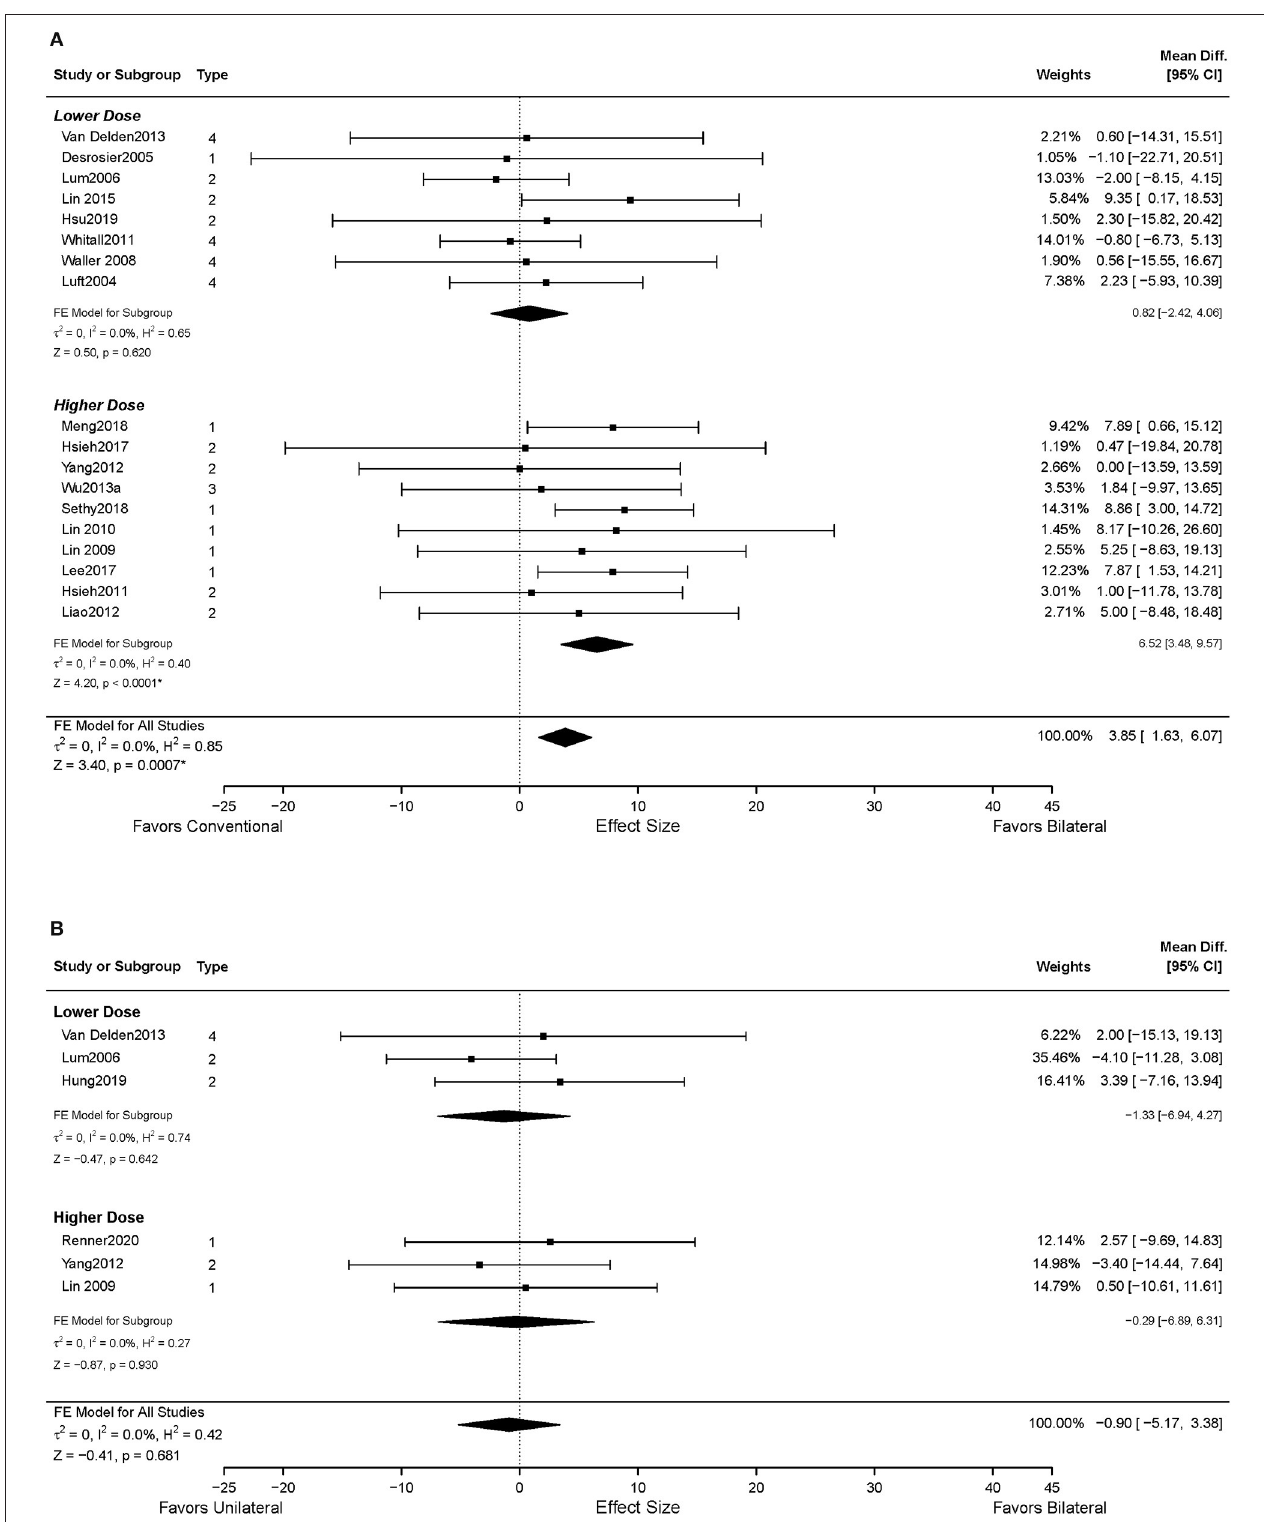
FIGURE 4 | The effects of intervention dose on the UE motor impairment. (A) BAT vs. CT; (B) BAT vs. UAT. 1 = bilateral functional training Test (BFTT); 2 = bilateral robot-assisted training (BRAT); 3 = bilateral arm training with rhythmic auditory cueing (BATRAC); 4 = mirror therapy (MT); BAT, bilateral arm training; CI, confidence interval; CT, conventional therapy; FE, fixed-effects; RE, random-effects; Std. Mean Diff., standardized mean difference; UAT, unilateral arm training; * indicates statistically significant ( p < 0.05).